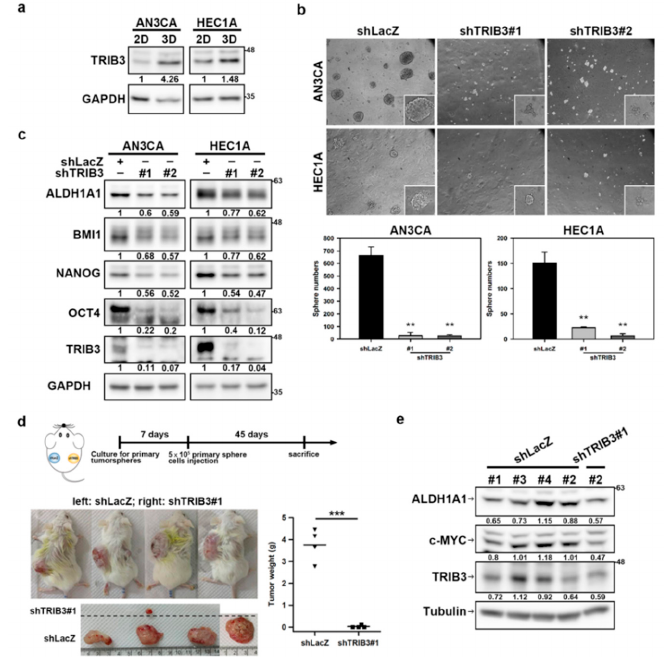
Figure 4. Knockdown of TRIB3 impaired self-renewal capability and tumorigenicity of EC cancer stem cells (CSCs). ( a ) Protein expression levels of TRIB3 in conventional adherence (two-dimensional, 2D) or tumorsphere (3D) cultured AN3CA or HEC1A cells were determined by Western blot. ( b , c ) AN3CA or HEC1A cells were transduced with shLacZ or TRIB3 specific shRNA (#1 or #2) carrying lentiviruses and selected with 2 µ g / mL puromycin for 3 days. The survived cells were then performed tumorsphere cultivation for 7 days followed by picturing (upper panel) and counting the number (lower panel) of formed tumorspheres with inverted light microscopy. Data represent the mean ± SD. ** p < 0.01, *** p < 0.001 when compared to shLacZ transduced cells ( b ). Specific amounts (25 µ g) of total cellular proteins from shRNA transduced AN3CA or HEC1A cells were subjected to determine the expression of indicated proteins by Western blot analysis ( c ). ( d ) NOD / SCID mice were injected subcutaneously with 5 × 10 5 cells of AN3CA-shLacZ or AN3CA-shTRIB3 primary tumorsphere cells and the tumor formation was monitored until day 45 post injection ( upper panel ). The central panel shows the appearance of tumor-bearing NOD / SCID mice implanted with AN3CA-shLacZ ( left site ) or AN3CA-shTRIB3 cells ( right site ). The lower panel indicates the excised tumor masses followed by weighing. *** p < 0.001 compared to control shLacZ-transfected group. ( e ) The expressions of aldheyde dehydrogenase (ALDH1A1), c-MYC, and TRIB3 protein in xenografted tumors from one experimental repeat with a small engrafted tumor after injection of TRIB3-knockdown AN3CA cells were examined by Western blotting